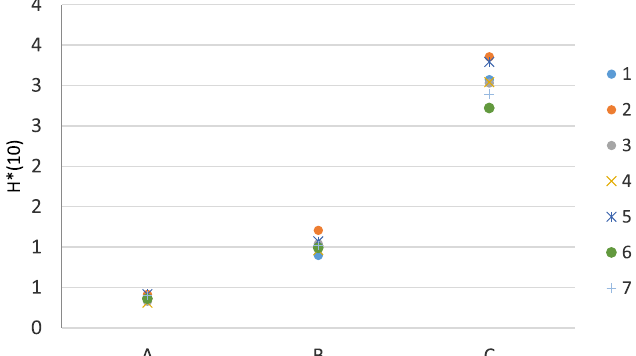
Fig. 7. Ambient dose equivalent rate H*(10)H*(10), in microSv/h, measured in points A, B and C by the 7 different equipments used.